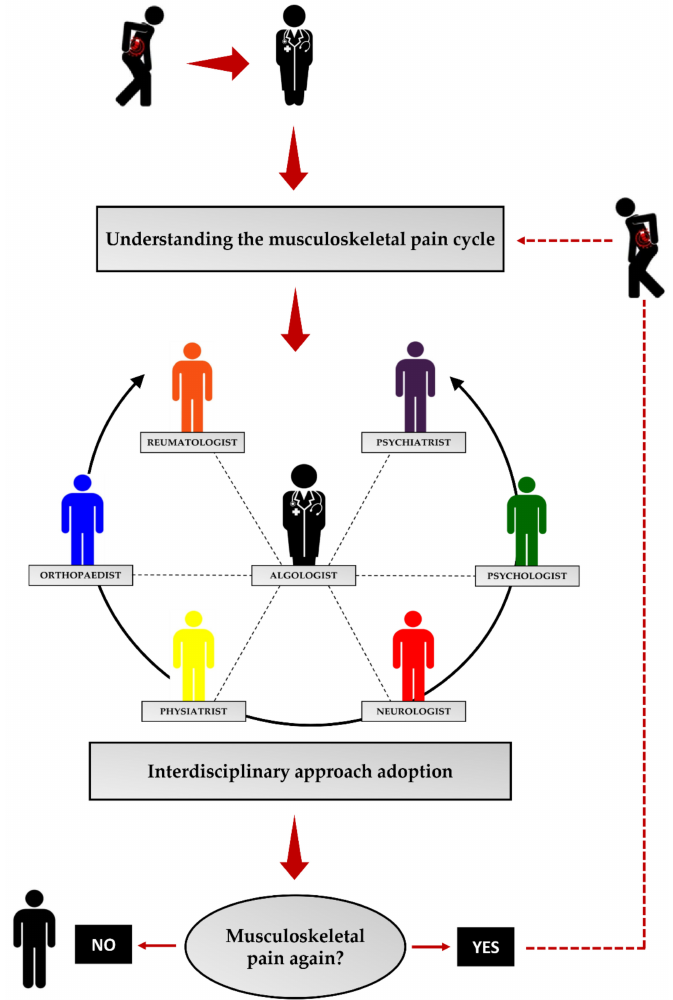
Figure 4. Possible management algorithm for the patient with musculoskeletal pain. An understand- ing of the musculoskeletal pain cycle may be the starting point for the development of an appropriate management algorithm for the musculoskeletal pain patient. If the patient understands the risks of a superficial and inconsistent approach, he/she will be more cooperative in accepting the therapy provided by a multidisciplinary team. Particularly, an algologist or pain specialist should play the role of team leader of a specialist team, such as an orthopaedist or bone specialist, a physiatrist or specialist in physical and rehabilitation medicine, a neurologist or nerve specialist, a psycholo- gist and a psychiatrist or mental health specialists, and a rheumatologist or specialist of joints and musculoskeletal system. In addition, if therapy proves ineffective, knowledge of the pain cycle may reduce the likelihood of counterproductive and self-defeating behaviour, promoting greater adherence to